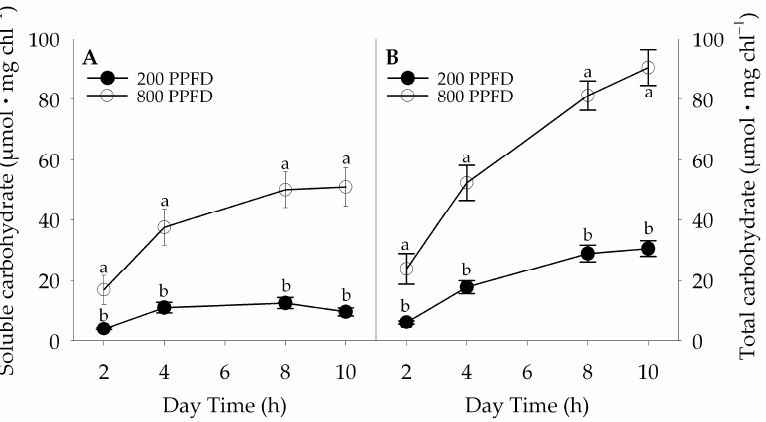
Figure 2. Soluble ( A ) and total carbohydrates content ( B ) during the light period in leaves of plants grown under 800 µ mol m − 2 s − 1 (800 PPFD) and 200 µ mol m − 2 s − 1 (200 PPFD) white light intensity. Mean values ± S.E. (n = 12). Different letters indicate significant differences at p = 0.05 (Fisher’s post-hoc test).